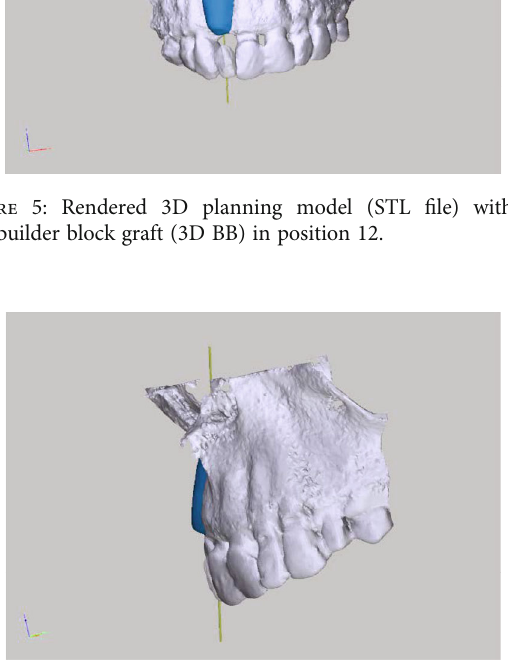
Figure 6: Rendered 3D planning model (STL fi le) with 3D BB in the transversal